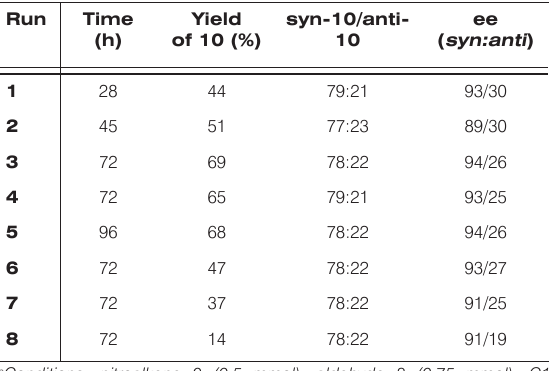
Table 4. C1 recycling in the reaction of 8 with 9 in [bmim]NTf Run